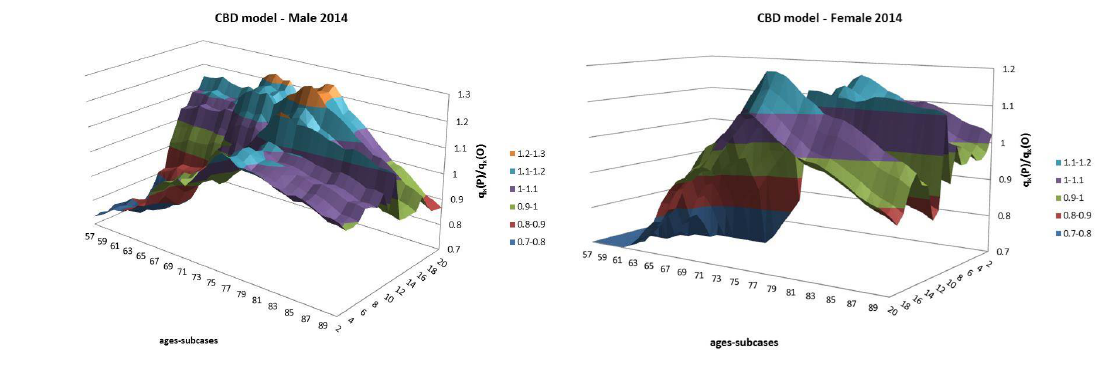
P x , t ratio 2014. q O x , t